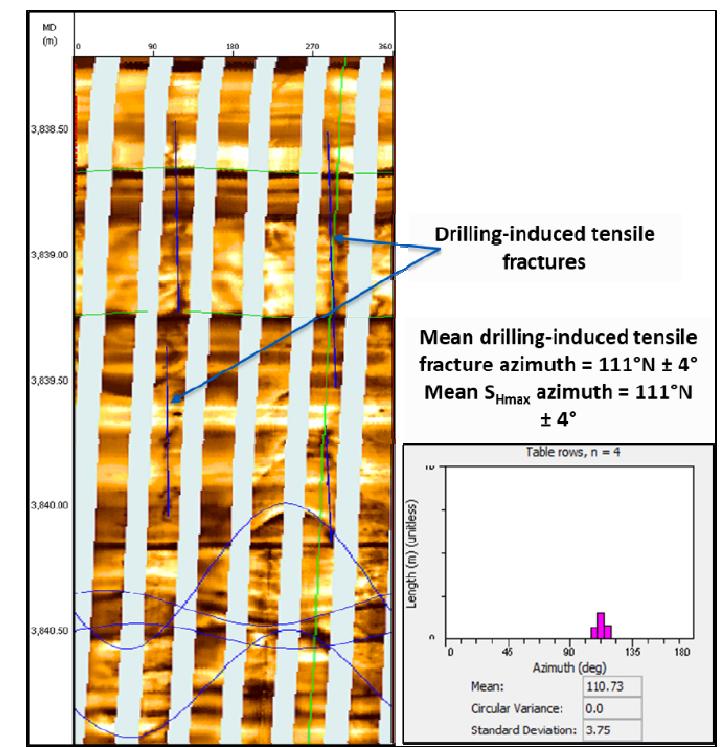
Figure 11. Enhanced Micro-resistivity Imaging (XRMI) analysis of R202.